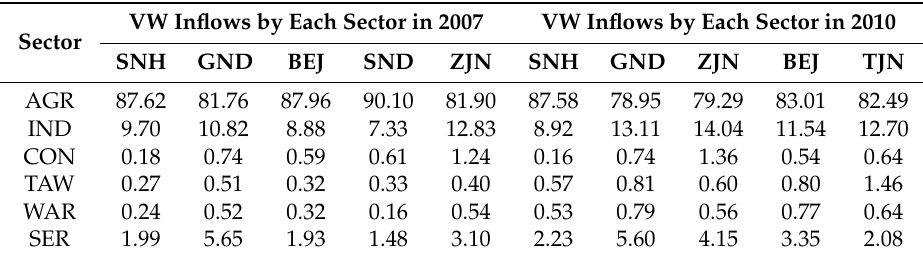
Table 2. Sectoral proportions of VW flowing into the five regions of China with the largest net inflows for the years, 2007 and 2010 (units: %).